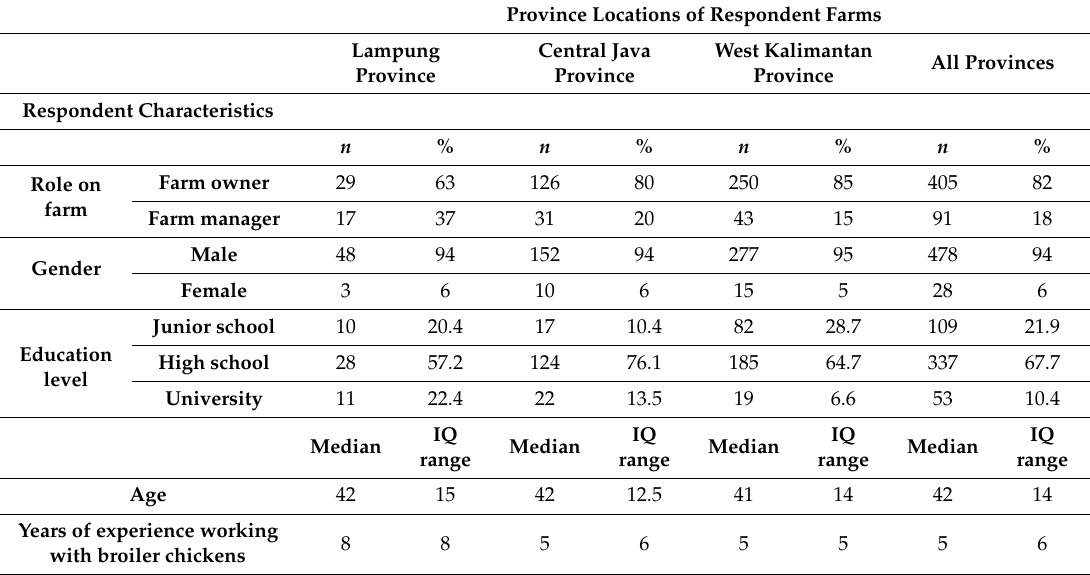
Table 1. Demographic information on the respondents and the respondent